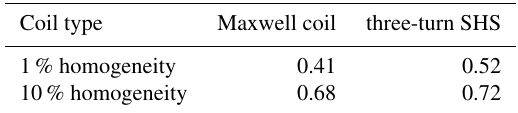
Table 2. Three-turn axisymmetric coil homogeneity: comparison between the Maxwell and the three-turn SHS coils.